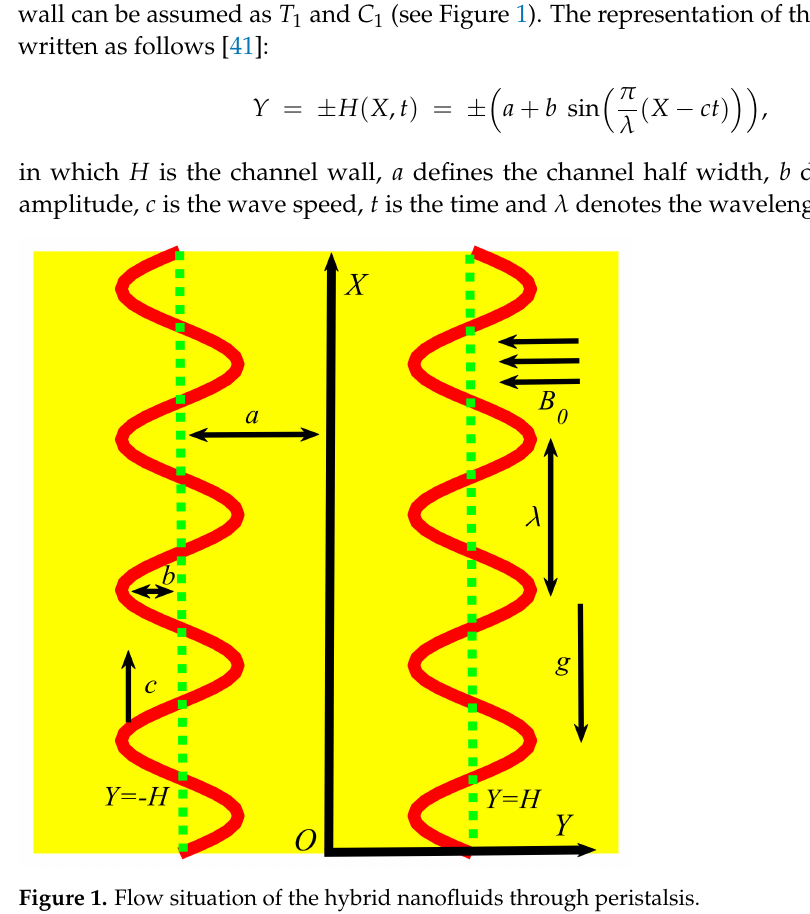
Figure 1. Flow situation of the hybrid nanofluids through